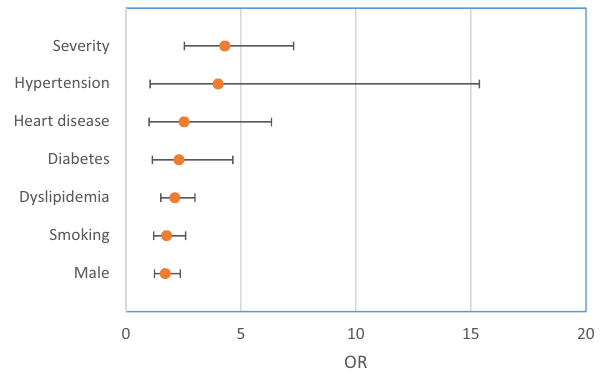
Fig. 5 Forest plot of the pooled estimate of significant risk factors for neurological associations in COVID-19 patients